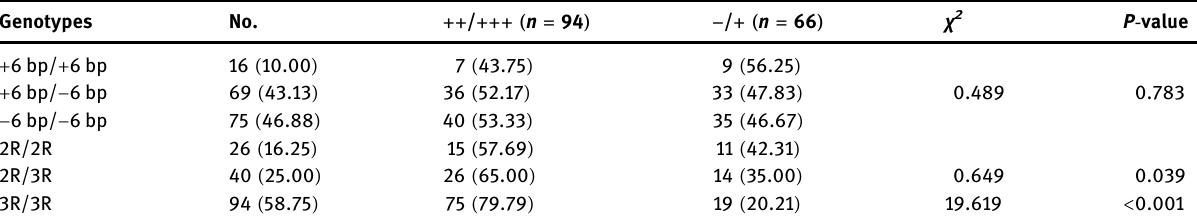
Table 3: The relationship between TS gene polymorphism and TS protein expression Genotypes